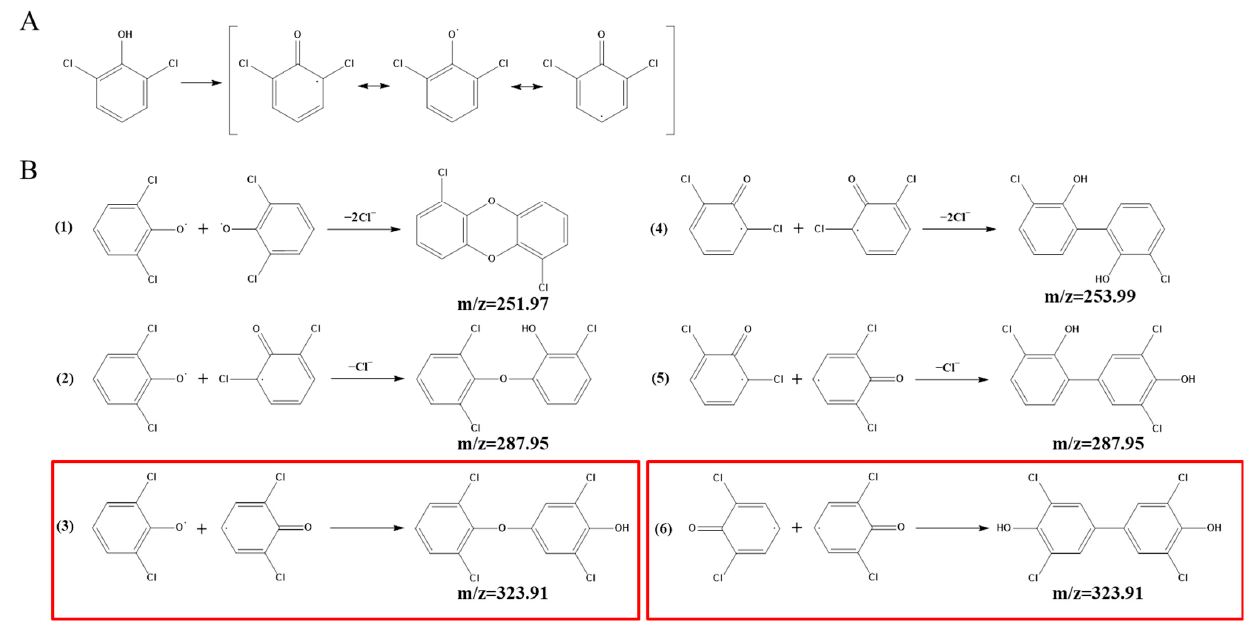
30 of 44 Figure 10. Mass spectrum (MS) of degradation products of 2,6-DCP degraded by LAC-4. Three products were detected by GC-MS analysis: the m/z values of substances I, II and III were 324, 323.8 and 321.9, respectively. Studies have shown that laccase catalyzes the formation of free radicals by chloro- phenols, and an oxidative coupling reaction occurs between the free radicals. The binding positions of the two free radical monomers in the coupling reaction are related to the po- sition of the lone pair electrons of the free radicals [30]. Based on the above GC-MC results, we speculate that 2,6-DCP was first oxidized by LAC-4 laccase to transfer one electron and one proton, generating three chemically stable free radicals (cationic radicals formed by meta-attack, unstable); then, six possible coupling reactions randomly occurred be- tween the free radical monomers (Figure 11). Among them, chloride ions were released during the reactions (2), (4) and (5). Due to the higher activity of free radicals in the form of oxygen and para positions, lone pair electrons were more likely to react with them. The O-para, O-O and para-para couplings took precedence over other couplings. The O-O re- action involves the ortho-chlorine atom, so reaction (1) in Figure 11 was less likely to oc- cur. Therefore, in conjunction with the m / z values of several products, it is postulated that substances I and II detected by GC-MS should be the dimers produced by reactions (3)